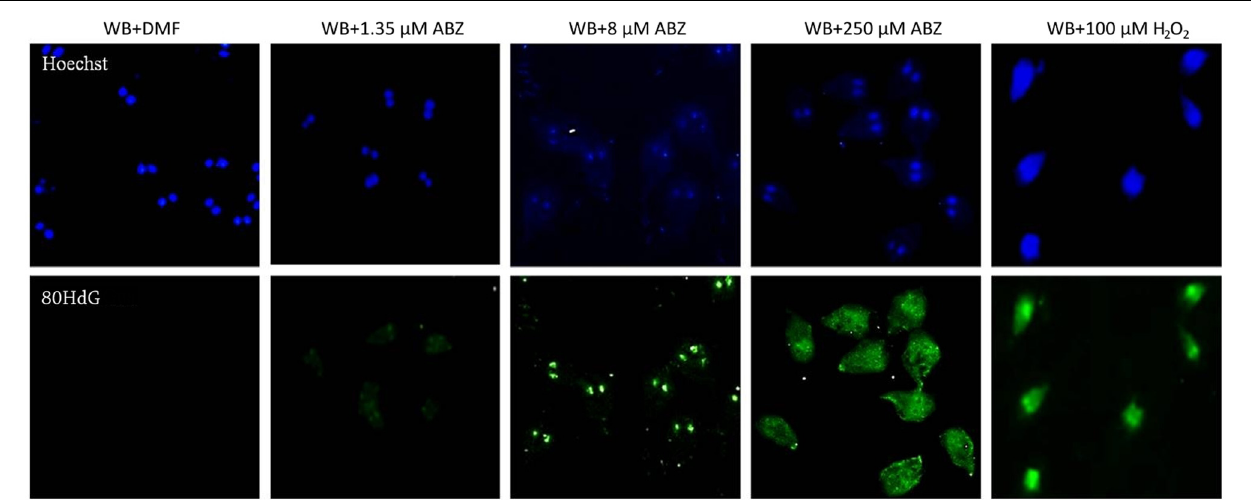
FIGURE 5 | Oxidative damage to DNA in G. duodenalis trophozoites exposed to ABZ. Parasites of the WB strain were exposed to DMF, 1.35 μ M, 8 μ M, 250 μ M of ABZ or 100 μ M of H 2 O 2 (the latter as control of ROS damage) for 8 h at 37 ◦ C. Then trophozoites were fixed on slides and incubated with the anti-8-hydroxydeoxyguanosine monoclonal antibody to detect modified